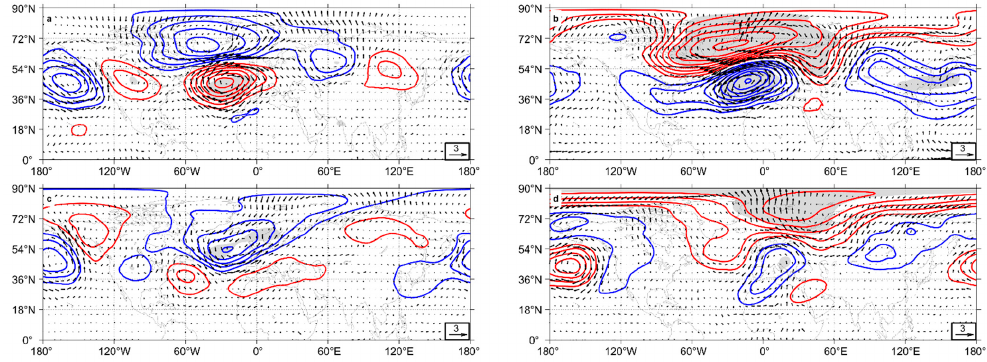
Figure 10. Synthetic analysis of the 500 hPa HGT anomaly field (contour lines, unit: gpm) and 850 hPa wind anomaly field (arrows, unit: m/s) (high ( a )/low ( b ) SI years in the Barents-Kara Sea region; high ( c )/low ( d ) SI years in the Chukchi Sea region) (red contour lines mean positive HGT anomaly, blue contour lines mean negative HGT anomaly, the contour lines interval is 5 gpm, grey shaded area through the test of significance of 95%).